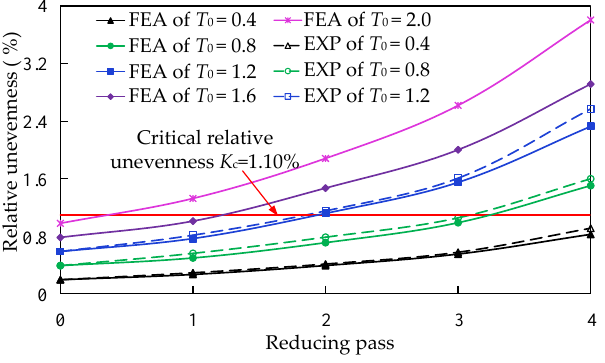
Figure 18. Relative unevenness of the end.